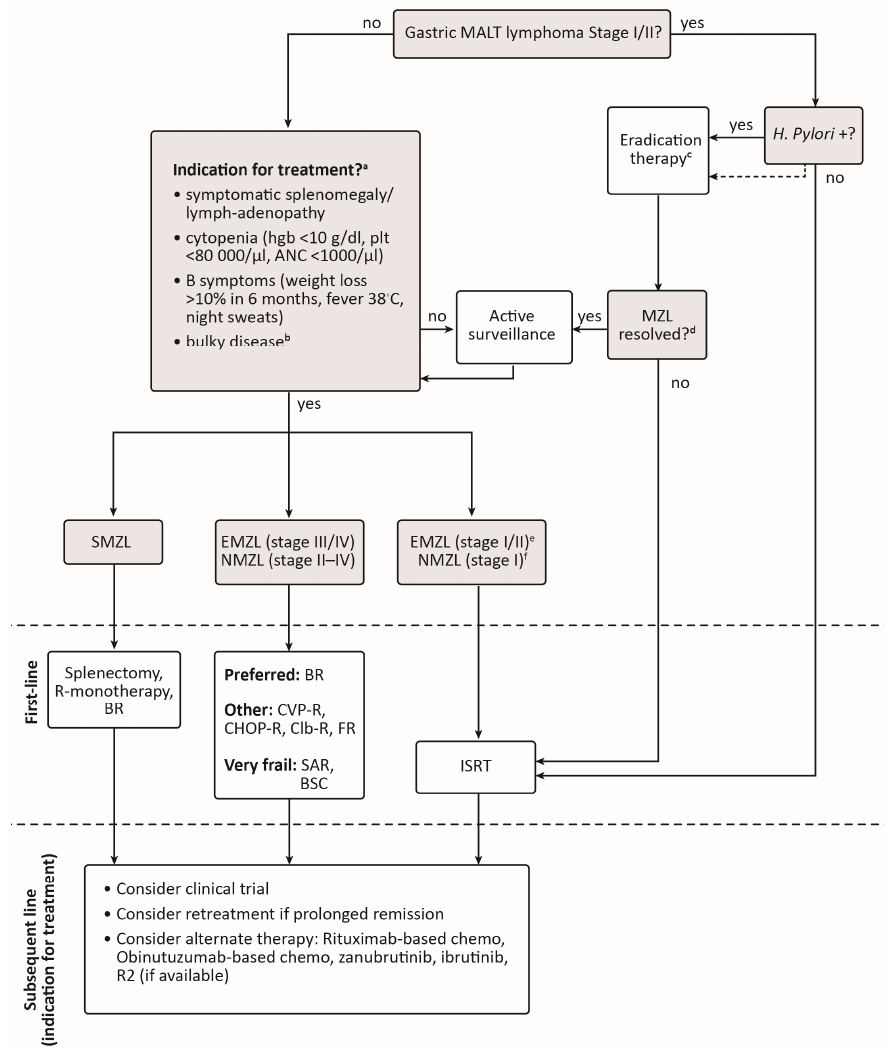
Figure 1. Suggested algorithm for the treatment of marginal zone lymphoma in Canada. a If patient is positive for Hepatitis C infection, treat first with antiviral therapy if immediate disease control is not needed. b Bulky disease is not clearly defined for MZL and may be considered as >7 cm as per GELF (Groupe d’Etude des Lymphomes Folliculaires) criteria for follicular lymphoma [104] or >10 cm, depending on individual practice. c H. pylori eradication therapy should be confirmed ≥ 4 weeks after treatment. If initial eradication therapy is unsuccessful, up to two additional trials of H. pylori eradication can be considered. d If H. Pylori eradication is confirmed, then serial scopes with biopsies should be performed every 3 months until a complete lymphoma response is reached. e Testing for C. psittaci in ocular adnexal MALT lymphoma is not routinely performed in Canada but may be considered. In patients who are C. psittaci -positive and do not require immediate disease control treatment with doxycycline may be considered. f Stage I NMZL is extremely rare, but ISRT may be considered in these patients based on extrapolation from studies in follicular lymphoma suggesting a chance for a functional cure [105,106]. ANC, absolute neutrophil count; BR, bendamustine-rituxi- mab; Bruton’s tyrosine kinase; BSC, best supportive care; CHOP-R, cyclophosphamide-doxorubi- cin-vincristine-prednisone-rituximab; Clb-R, chlorambucil-rituximab; CVP-R, cyclophosphamide- vincristine-prednisone-rituximab; EMZL, extranodal marginal zone lymphoma; FR, fludarabine- rituximab; hgb, hemoglobin; ISRT, involved-site radiation therapy; MALT, mucosa-associated